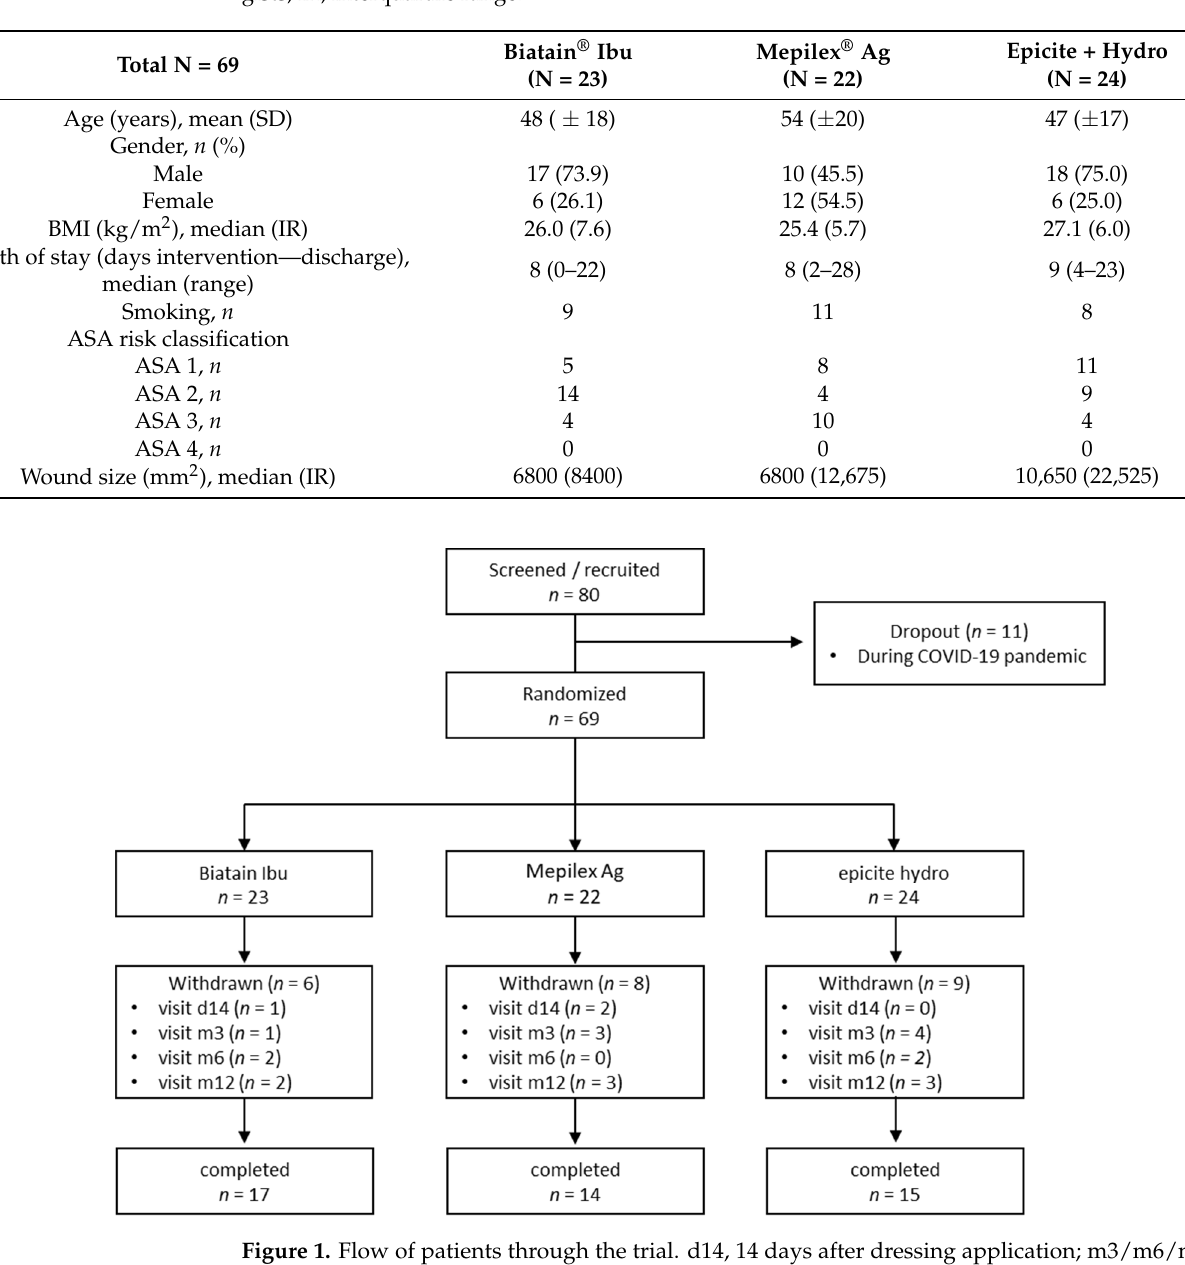
Table 1. Demographic variables and baseline characteristics. ASA, American Society of Anesthesi- ologists; IR, interquartile range.